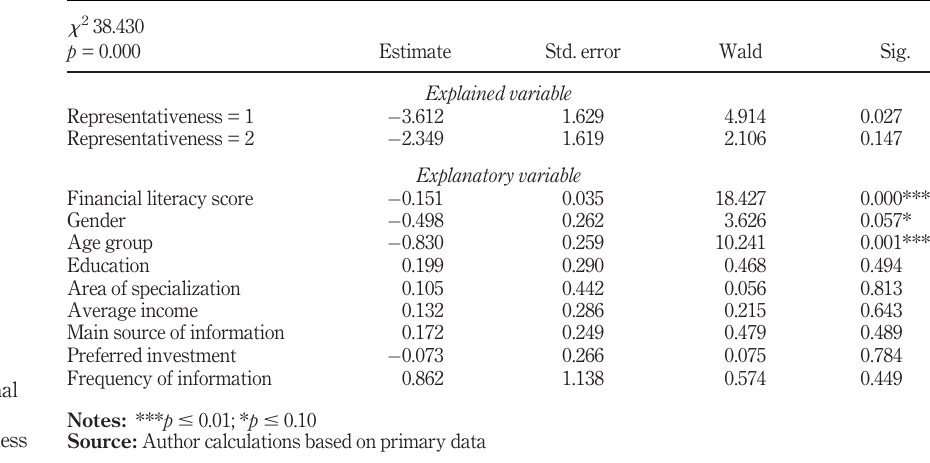
Table 6. Results of ordinal regression for